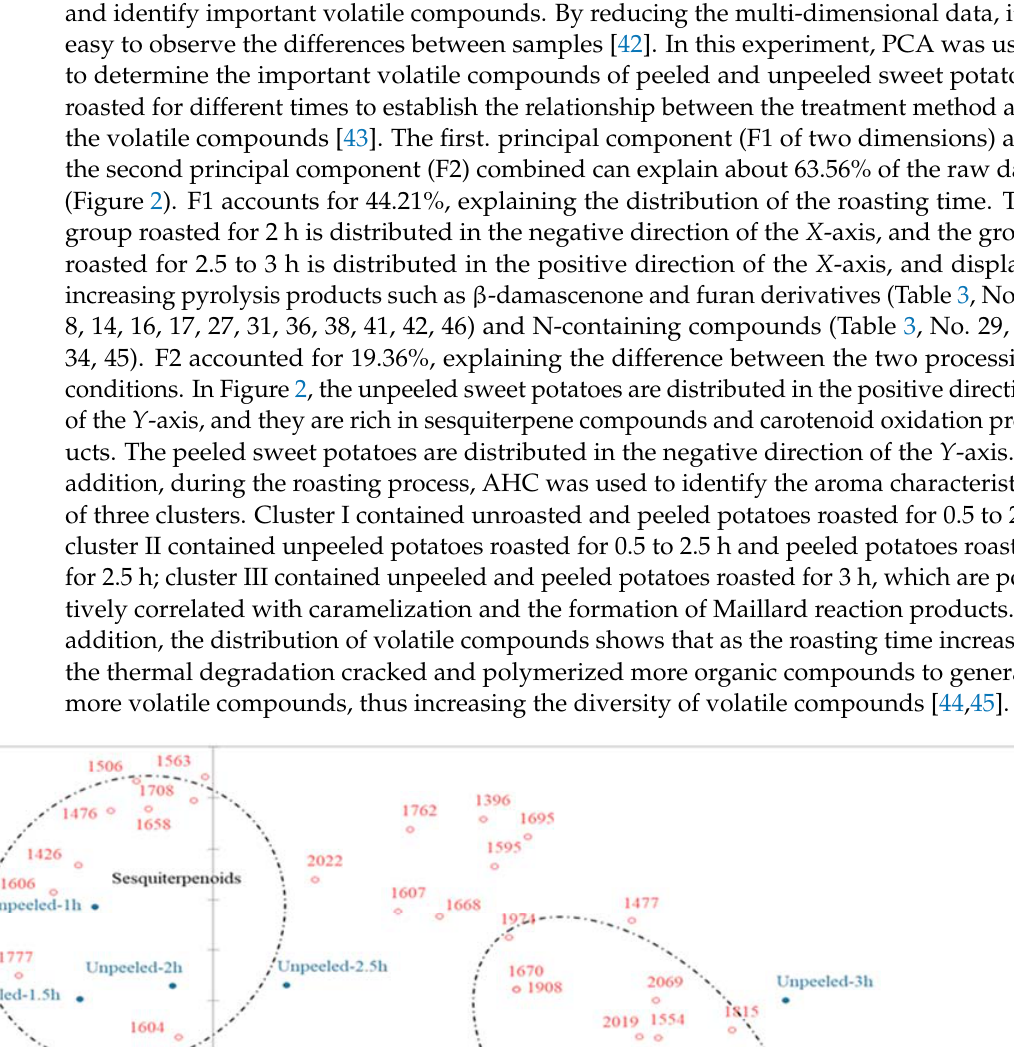
Table 3. Volatile compounds of sweet potatoes identified during roasting process.